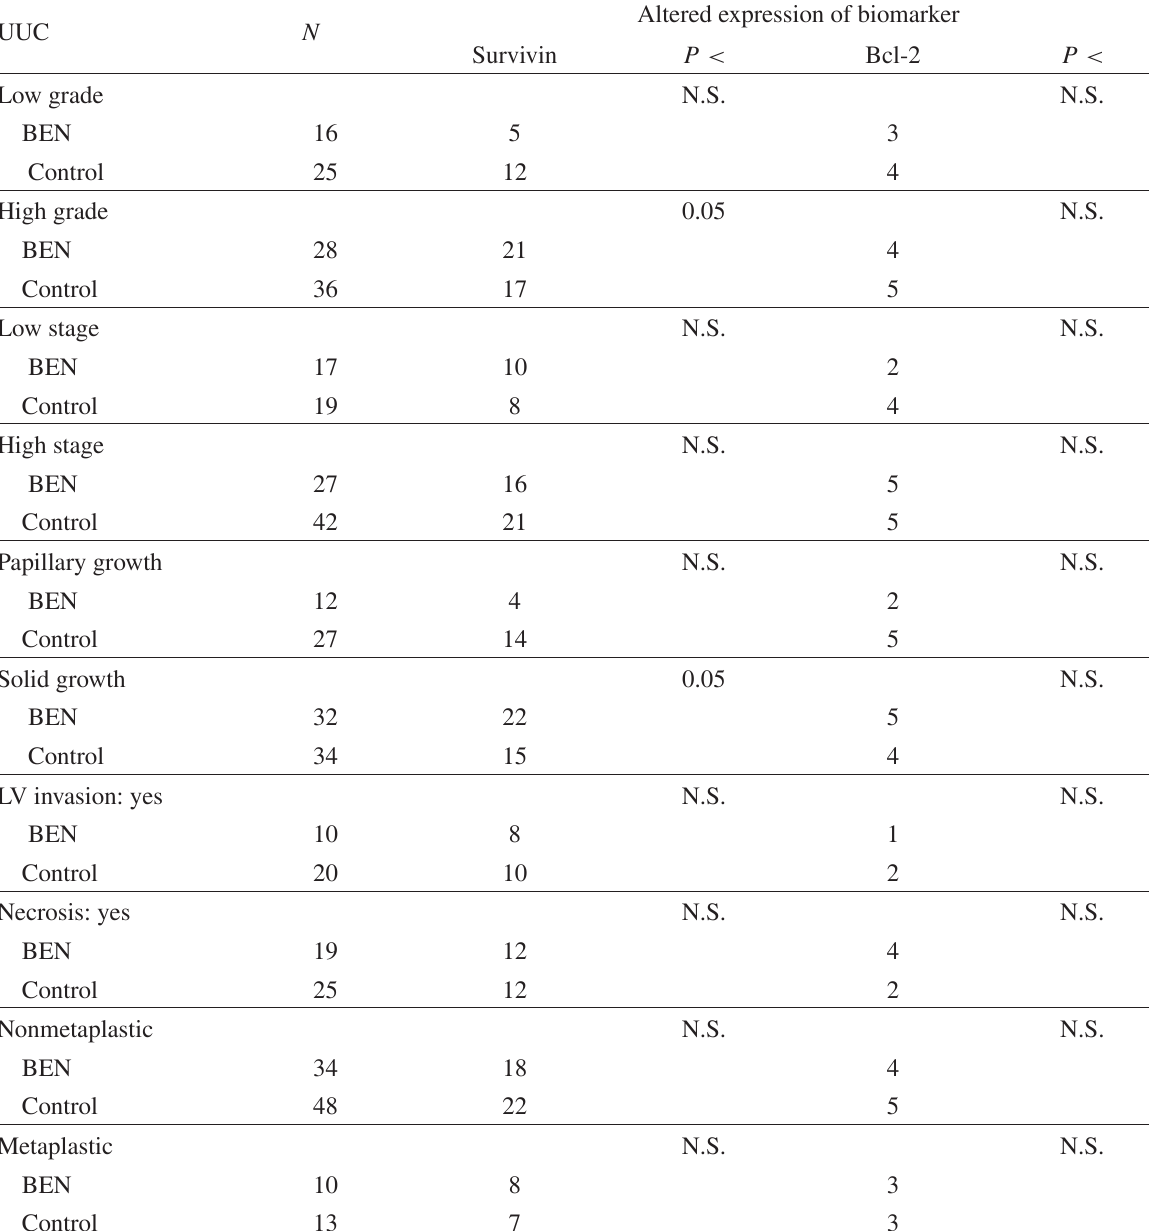
TABLE 1: Association of antiapoptotic biomarkers expression with pathological characteristics of